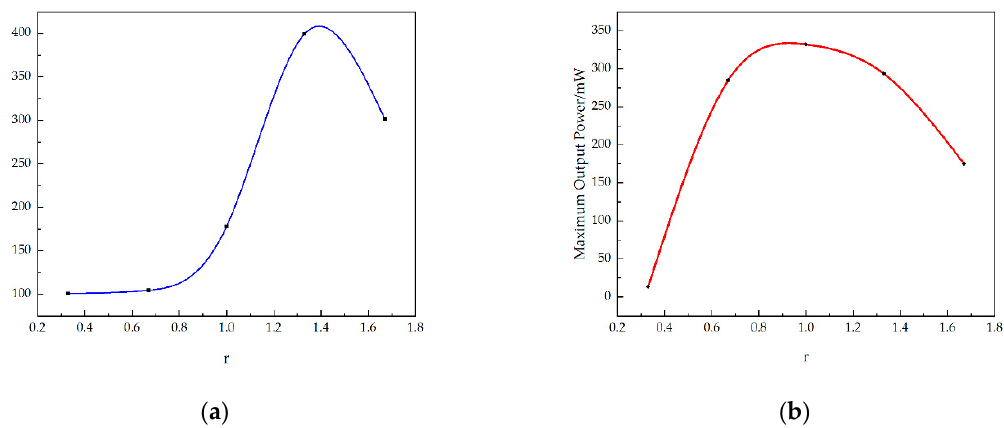
Figure 11. ( a ) Maximum output voltage of the STTM-PEH with different substrate thicknesses. ( b ) Maximum output power of the STTM-PEH with different substrate thicknesses.